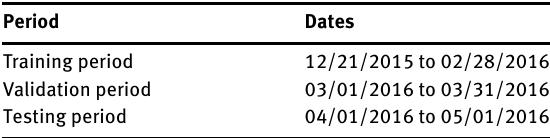
Table 1: Company-Centric Evaluation